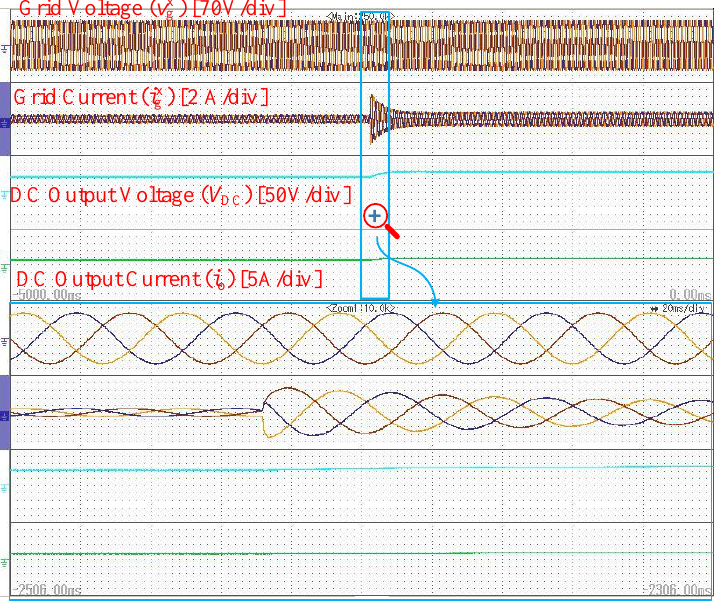
Figure 16. Experimental results during 30% rise in the DC voltage reference. A power electronics interface consisting of the proposed PFC rectifier and a typical buck–boost DC-DC converter is constructed to illustrate application in three-phase charging. The ratings are based on a three-phase input voltage of 170 VRMS at 50 Hz and a rectifier output DC voltage of 100 V. The voltage and current of the battery are 48 V and 16 A, respectively. Figure 17 depicts the battery charging, where the waveforms indicate that the grid voltage and current are in phase. The rectifier’s output voltage is controlled to 100 V DC and further regulated to battery voltage 48 V using a DC-DC converter.